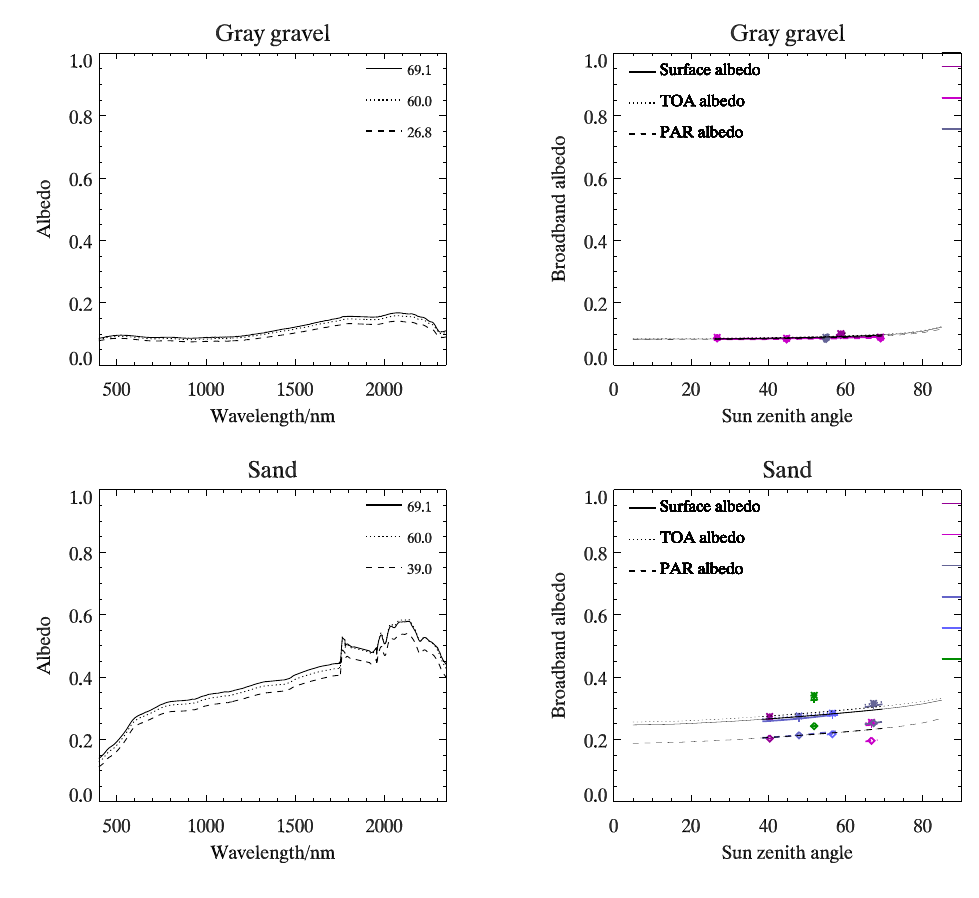
Figure 4. Left: The spectrally-resolved hemispherical albedo at three angles of incidence: maximum, minimum and 60 ◦ (interpolated). Right: recovered broadband surface albedo (solid line, +), TOA albedo (dotted line, x) and PAR albedo (dashed line, diamond) as a function of the solar zenith angle. The black thin lines represent the broadband albedo obtained by combining all measured samples. The coloured thick lines and symbols correspond to the different samples, as listed by collection date, and represent the broadband albedo obtained by applying all illumination angles together (lines) and single illumination angles separately (symbols). The thin lines extrapolate to almost the full range of illumination angles but give less reliable values than the thick lines. The targets are grey gravel and sand in the upper and lower panels,